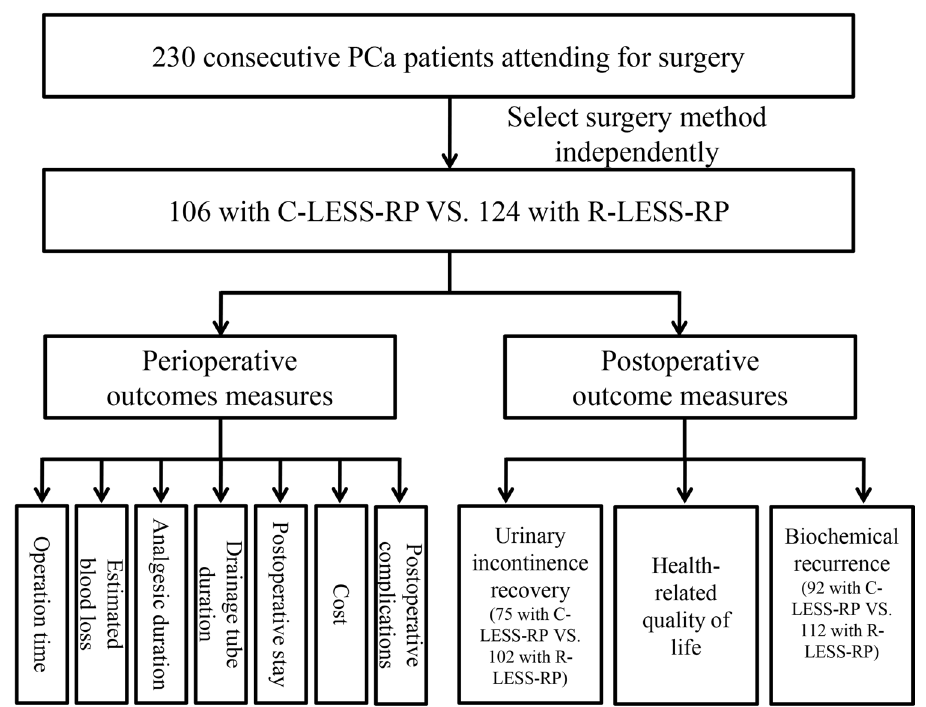
Figure 1. The flow chart of the